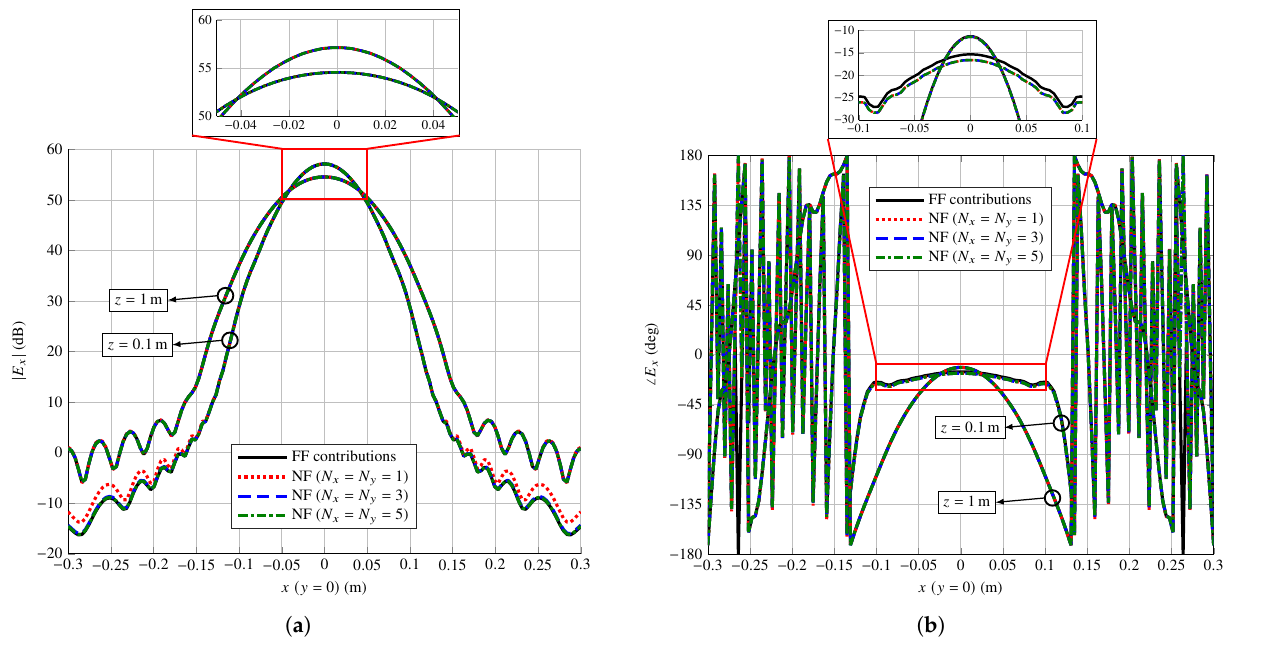
Figure 3. Comparison of the near field radiated by a center-fed transmitarray in ( a ) magnitude and ( b ) phase at the different z planes as calculated by the near field model based on the superposition of far field (FF) contributions of each array element, and the near field (NF) model based on the radiation equations for different values of N x and N y to assess the convergence in the numerical evaluation of the double integrals. Near field is plotted in the